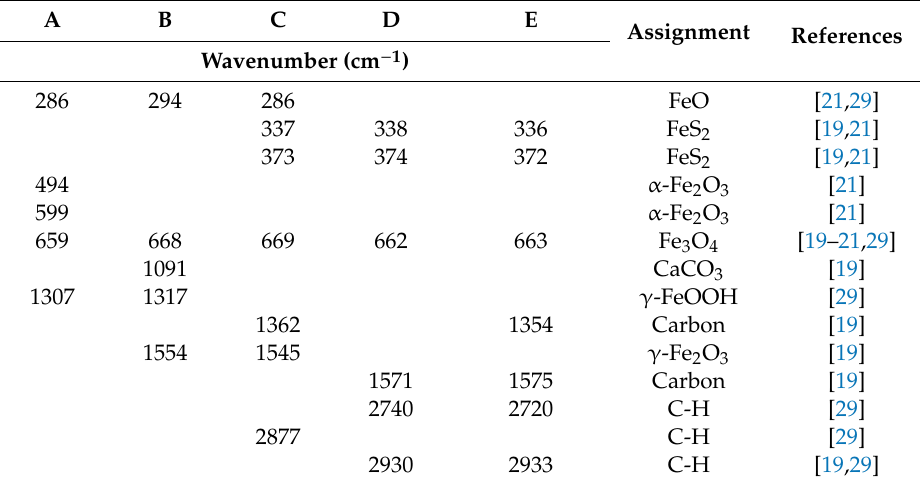
Figure 7. Raman spectra recorded from the friction tracks on plate samples A, B, C, D, and E. Table 4 lists the positions of the Raman bands, their origins, and corresponding references. Table 4. Summary of the Raman experiments.